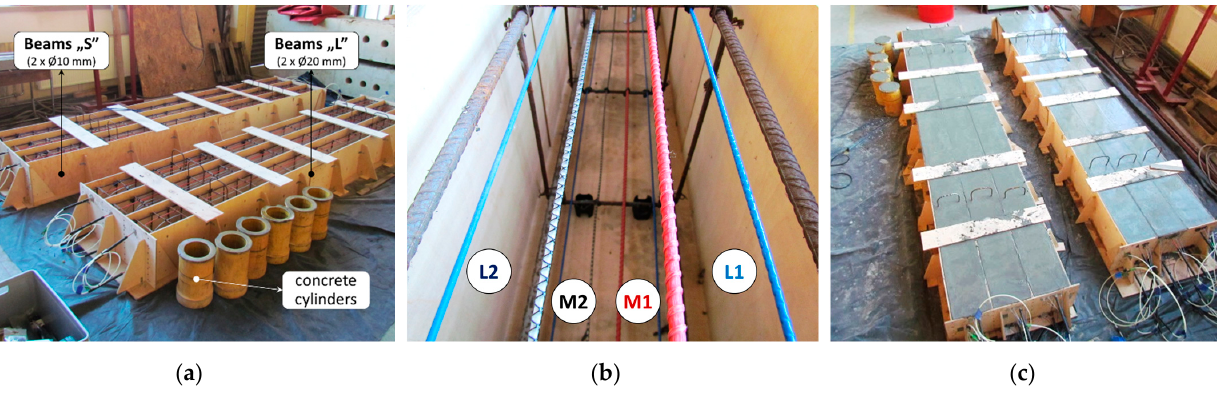
Figure 16. ( a ) View of formwork prepared for concreting; ( b ) close-up to the DFOS tools; ( c ) the view of the beams after concreting.